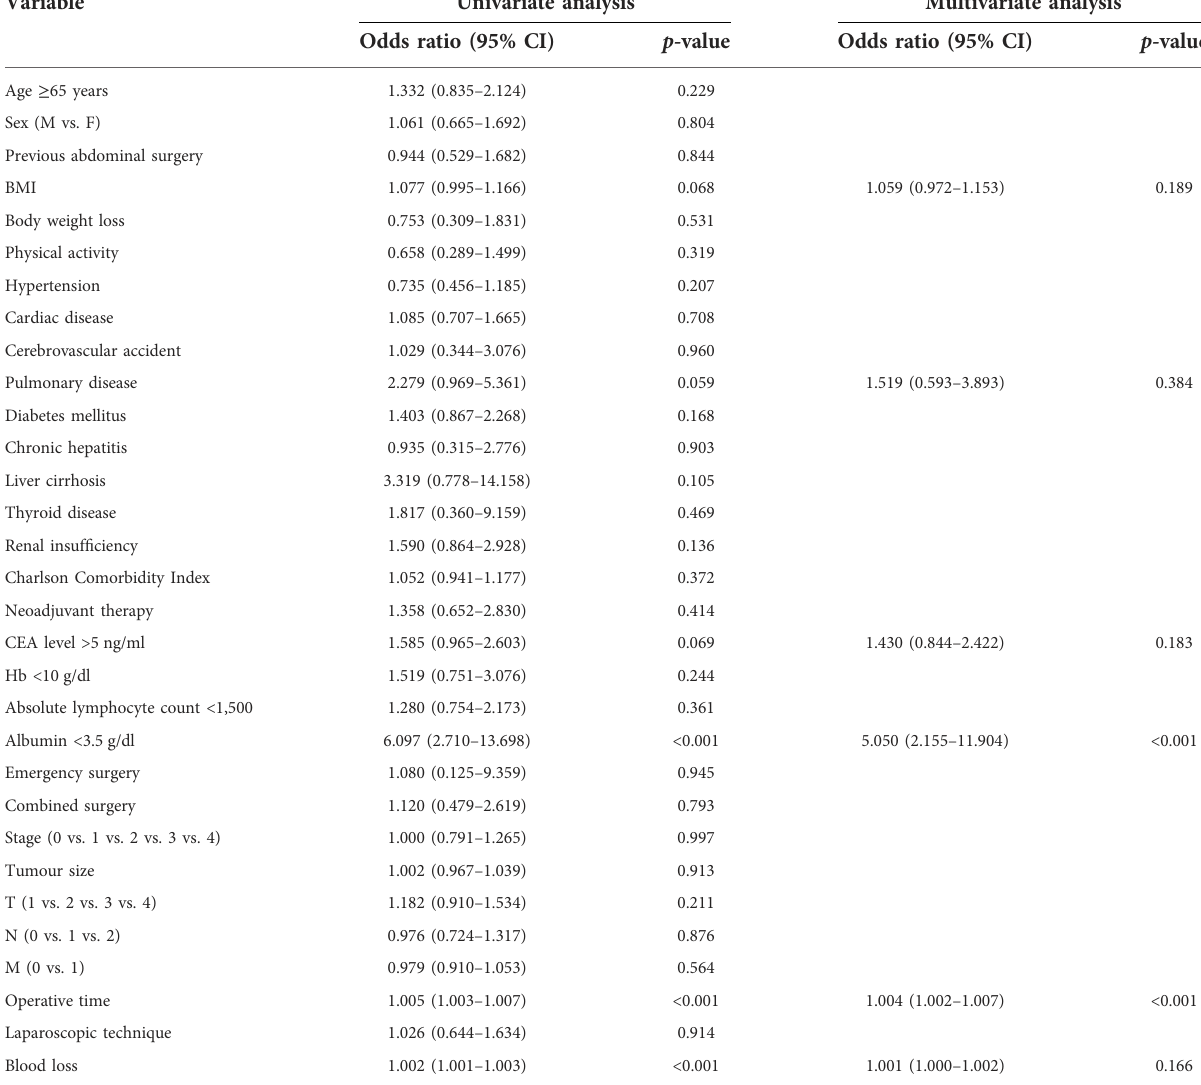
TABLE 4 Results of multivariable analysis of clinical factors in fl uencing postoperative